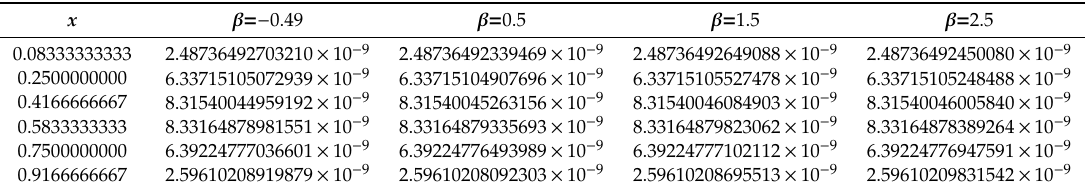
Table 2. For λ = 0.005 and α = 0.90, Maximum error ( L ∞ ) of example with the Gegenbauer wavelet Collocation method for various values of β .